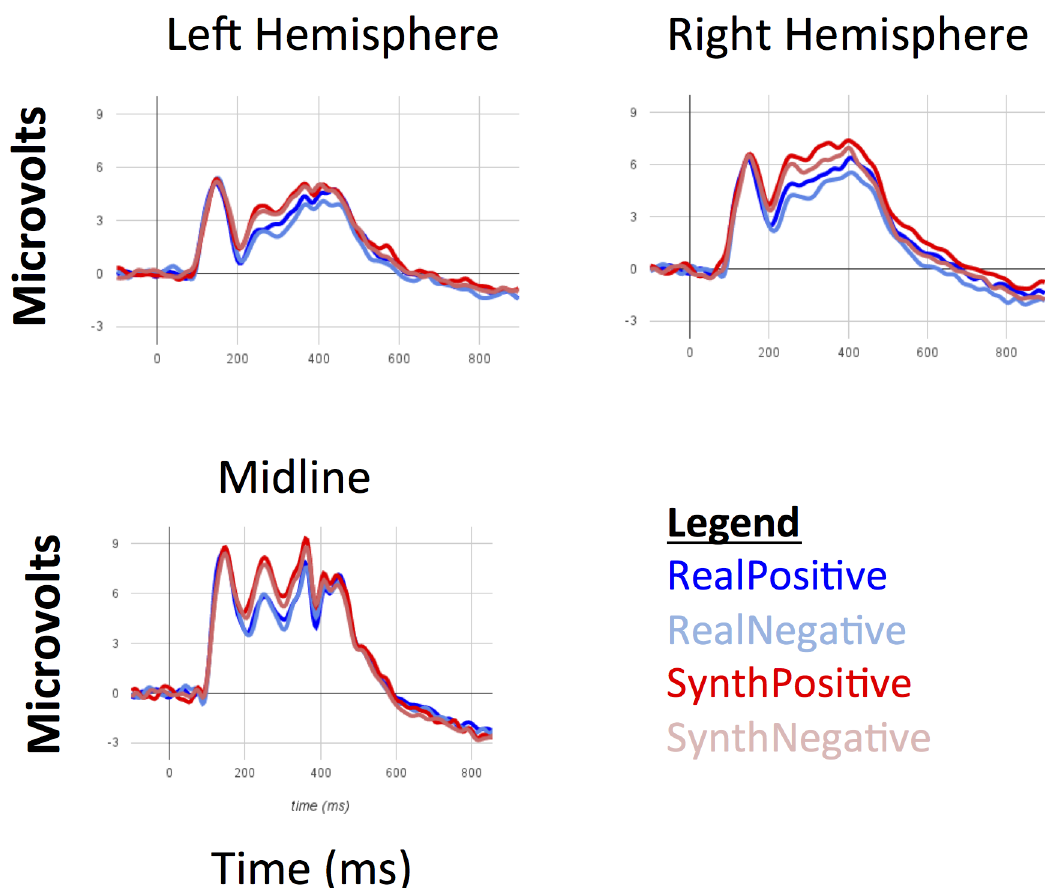
Fig 6. Grand average ERP waveforms for all stimulus conditions at left, midline and right occipital sites. While the P1 does not appear to be sensitive to either contrast negation or real/synthetic appearance, the N1 is sensitive to both.